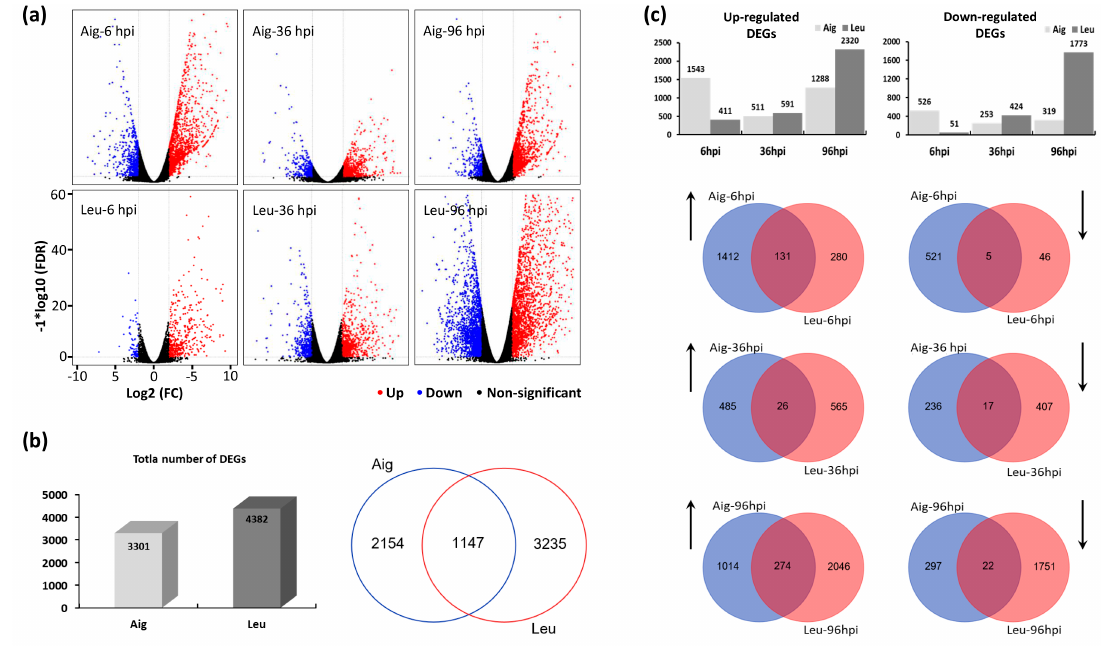
Figure 3. The number of differentially expressed genes (DEGs) in infection stages of two poplars. ( a ) Volcano Plot shows the number upregulated and downregulated DEGs in different stages of two poplars. ( b ) Histogram shows the number of all DEGs detected in two poplars. Venn diagram shows the overlapping of DEGs detected in two poplars. ( c ) Histogram shows the up or downregulated DGEs of poplars in different infection stages. Venn diagram shows the overlapping of up or downregulated DEGs between two poplar sections at three infection stages. Arrows indicate up or